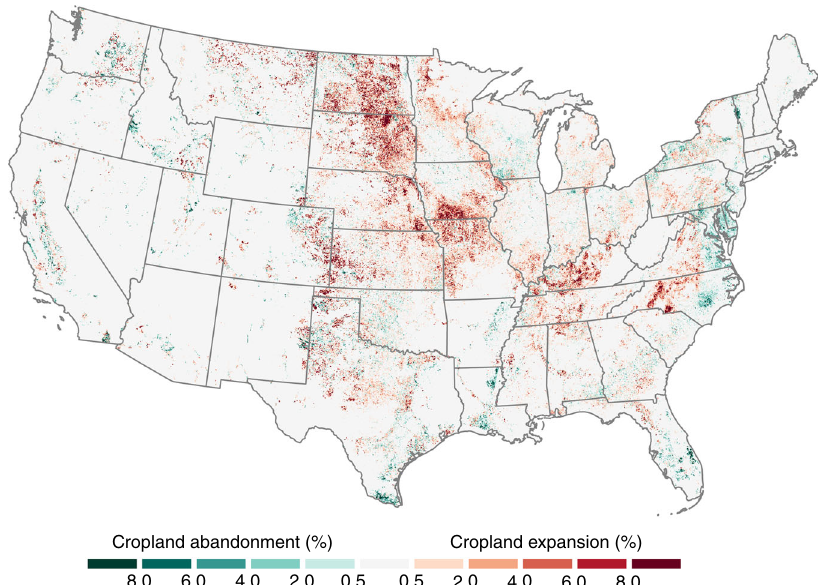
Fig. 1 Net cropland conversion 2008 – 16. Rates of net conversion calculated as gross cropland expansion minus gross cropland abandonment and displayed as a percentage of total land area within non-overlapping 3 km × 3 km blocks. Net conversion was most concentrated in the eastern halves of North and South Dakota, southern Iowa, and western portions of Kansas, Kentucky, and North